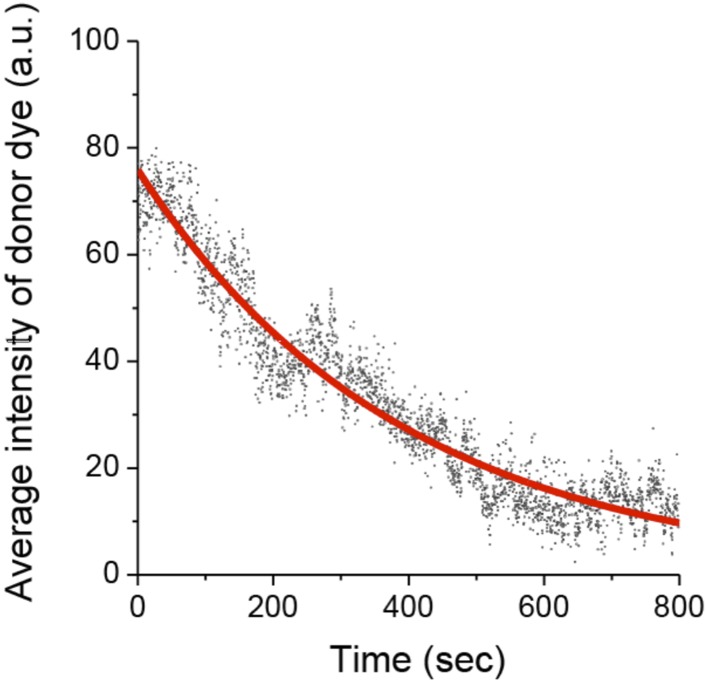
Photobleaching of the Cy3 donor.